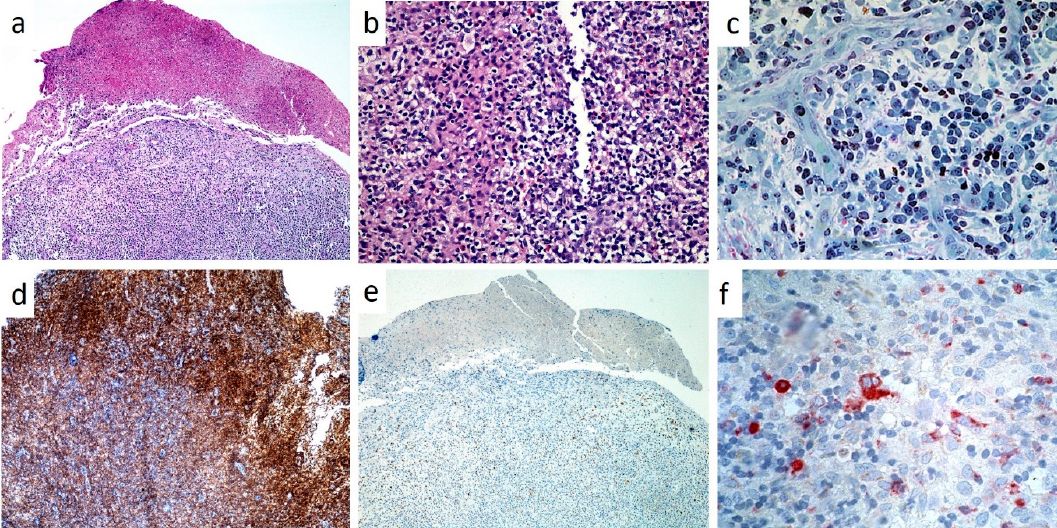
Figure 8. ( a – f ): Low ( a , H and E, X4) and high power magnification ( b , H and E, X10) of LCH of the gingiva, showing a partially ulcerated epithelium with abundant underlining infiltration of large cell with lobulated, indented nuclei and faintly eosinophilic cytoplasm intermixed with numerous eosinophils; toluidine blue staining on resin section (X20) showing large histiocytic cells with pale cytoplasm and eosinophils( c ); strong immunostaining for CD1A ( d ) and S-100 ( e ), mild/moderate for CD68 ( f ).